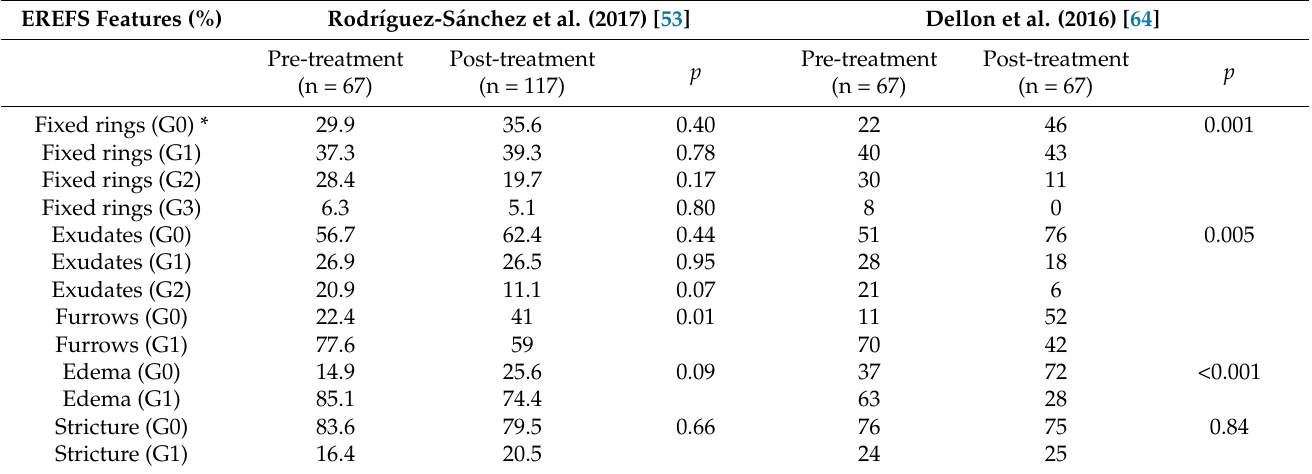
Table 1. Comparison of EREFS features and scores for EoE cases before and after